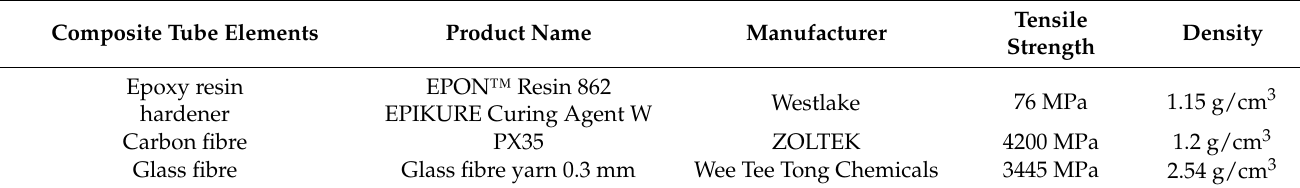
Table 1. The general information about the composite tube materials.